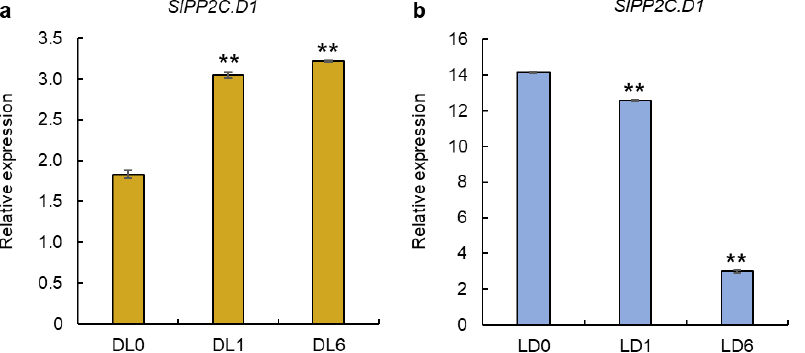
Figure 5. Light-responsive expression patterns of SlPP2C.D1 in hypocotyls of tomato seedlings. ( a ) Seven-day-old, dark-grown seedlings were exposed to white light for 0 h (DL0), 1 h (DL1), or 6 h (DL6). ( b ) Seven-day-old, light-grown seedlings were exposed to darkness for 0 h (LD0), 1 h (LD1), or 6 h (LD6). For ( a , b ), hypocotyls were dissected for RNA analysis by RT-qPCR. The tomato ACTIN2 gene was used as an internal standard. Values are means ± SD of three biological replicates. Asterisks refer to data significantly different from DL0 or LD0; Student’s t -test: ** p <